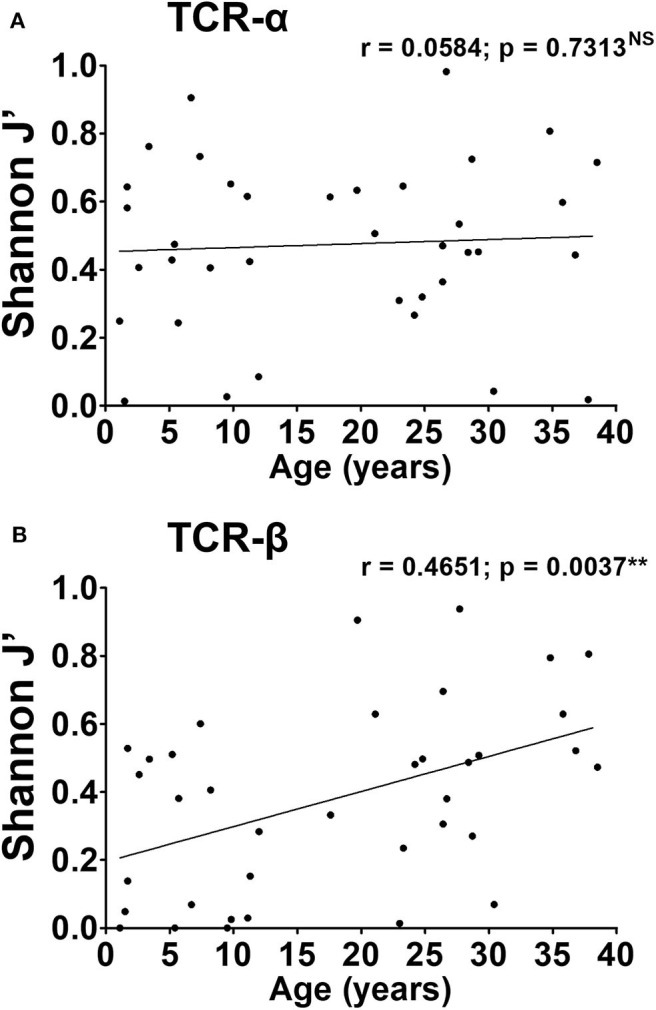
CMV-associated TCR repertoire perturbation arises in early life and is maintained over time. Oligoclonality of the TCR-α (A) and -β chain (B) repertoire was calculated as outlined in Materials and methods for each time point. J′ values of 0 have been used to represent monoclonal samples. Spearman's r was computed for every parameter and shown above the corresponding graph. P-values < 0.05 were considered significant (**p < 0.01, NS, not significant).